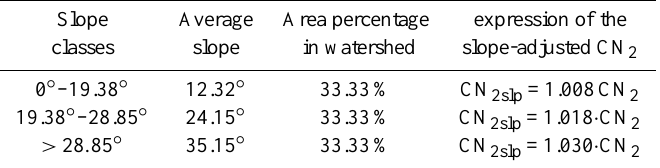
Table 2. The three classes of slope and the expressions of the slope-adjusted CN 2 .